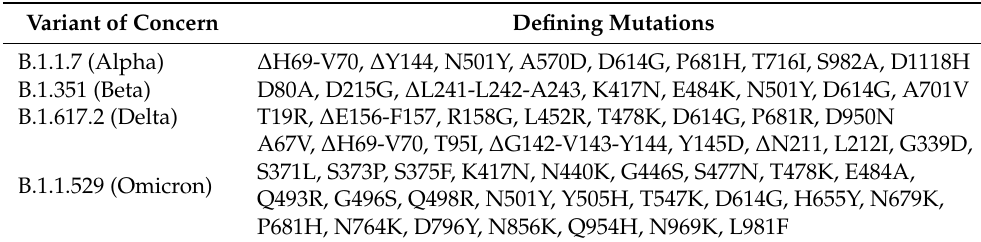
Table 1. The mutations, insertions or deletions characterizing the different variants simulated in this